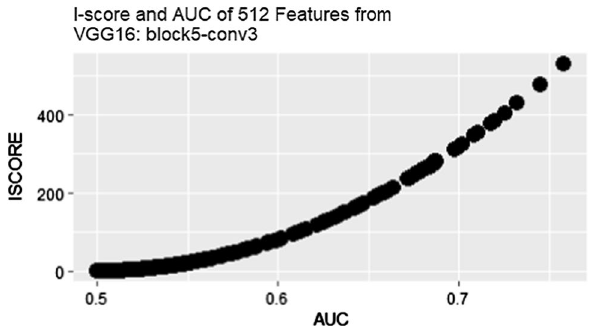
Fig. 11 Graph presents empirical relationship between proposed I-score and AUC. To plot this graph, we investigate the last convolutional layer (namely “block5-conv3”) in the VGG16 architecture, i.e. there are 512 of these features extracted. We compute I-score and AUC value for each one of the 512 features. In this experiment, we directly compute the I-score of each feature and we do not need to use BDA. Since there are 512 features, all of their I-score values are computed and we use I-score value to measure the explainability and predictivity of each feature. To provide readers intuition how powerful each I-score value is, we also compute AUC for each feature alone (that is, by treat- ing each feature itself as a predictor). The AUC values and I-score values are plotted for all 512 features in a scatter